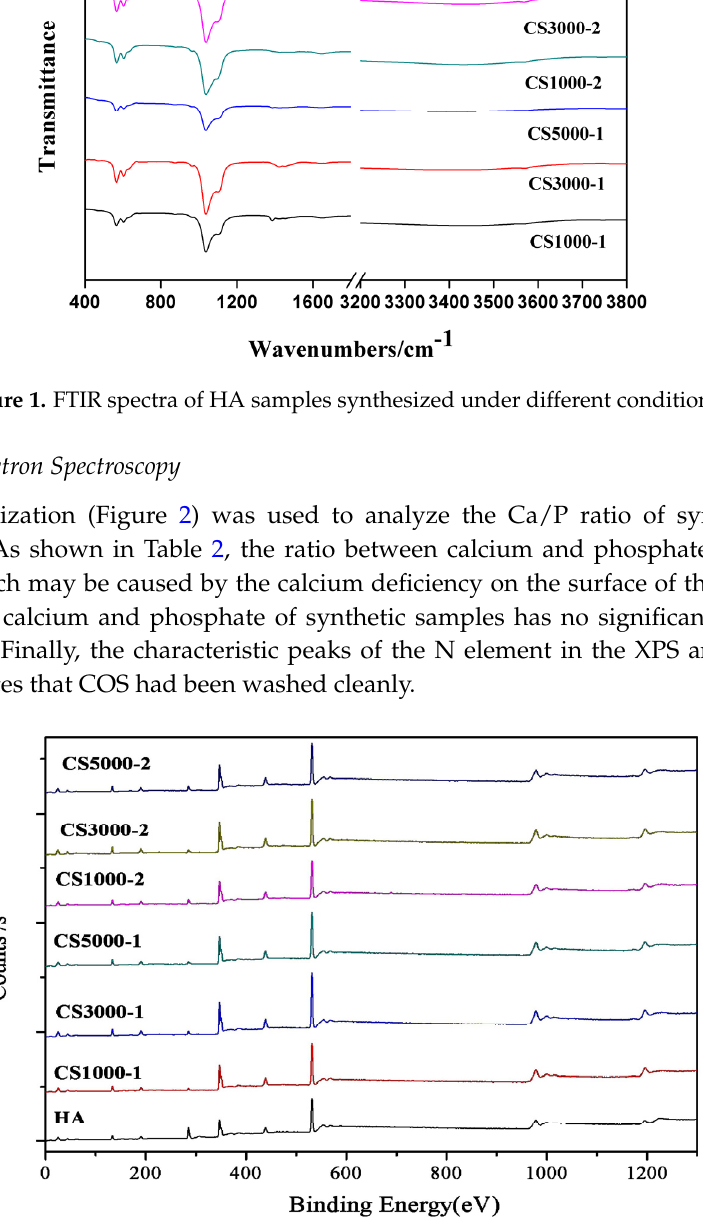
Figure 2. XPS spectra of as-synthesized HA samples under different conditions. Table 2. Quantities and molar ratios of synthesized HA samples.